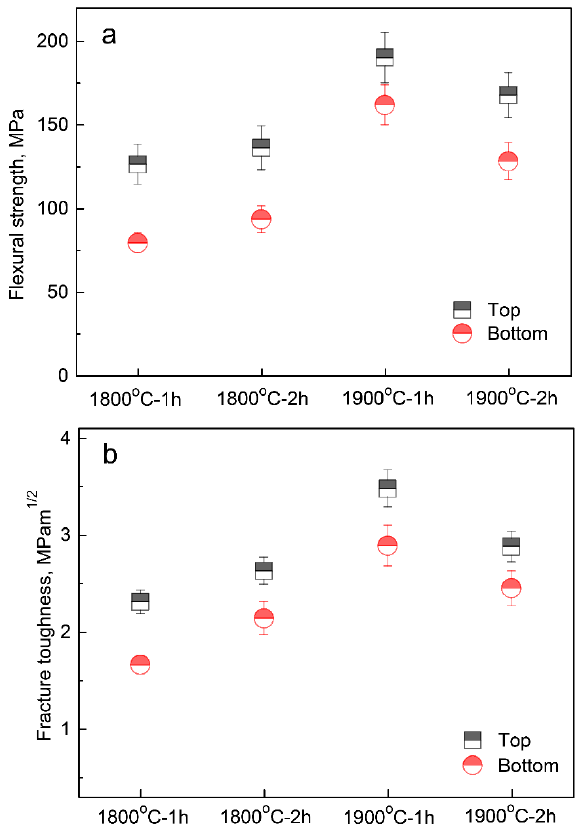
Figure 7. Flexural strength ( a ) and fracture toughness ( b ) of porous α -SiAlON samples fired at different conditions.